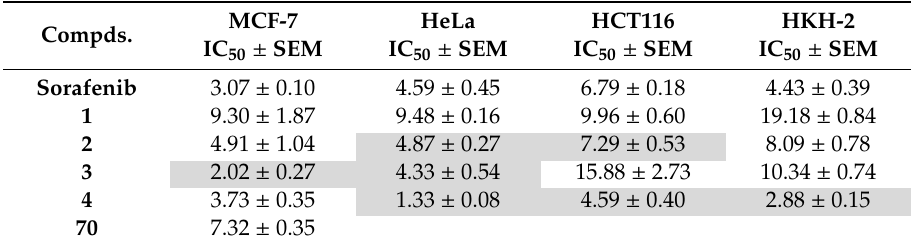
Table 2. E ff ect in viability of MCF-7, HeLa, HCT116, and HKH-2 cancer cells (IC 50 , µ M) of compounds 1 – 4 , 70 and sorafenib on the alamarBlue ® assays.